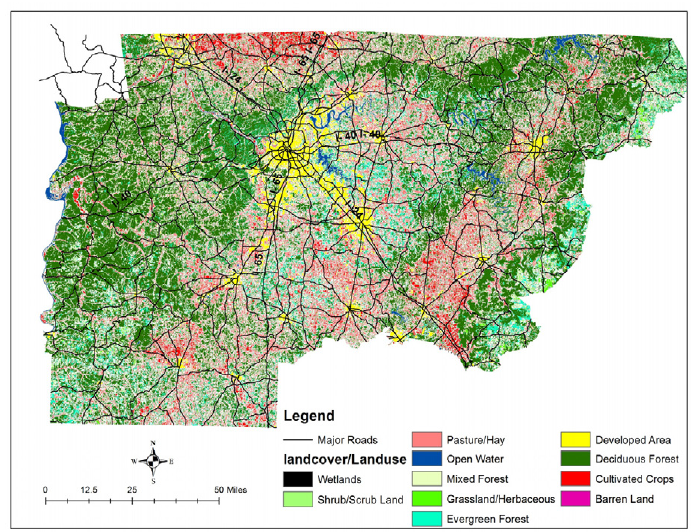
Fig. 3b: Input variable (Landcover/Landuse) used in modeling inland wetlands’ vulnerability to human and natural stressors by the year 2080